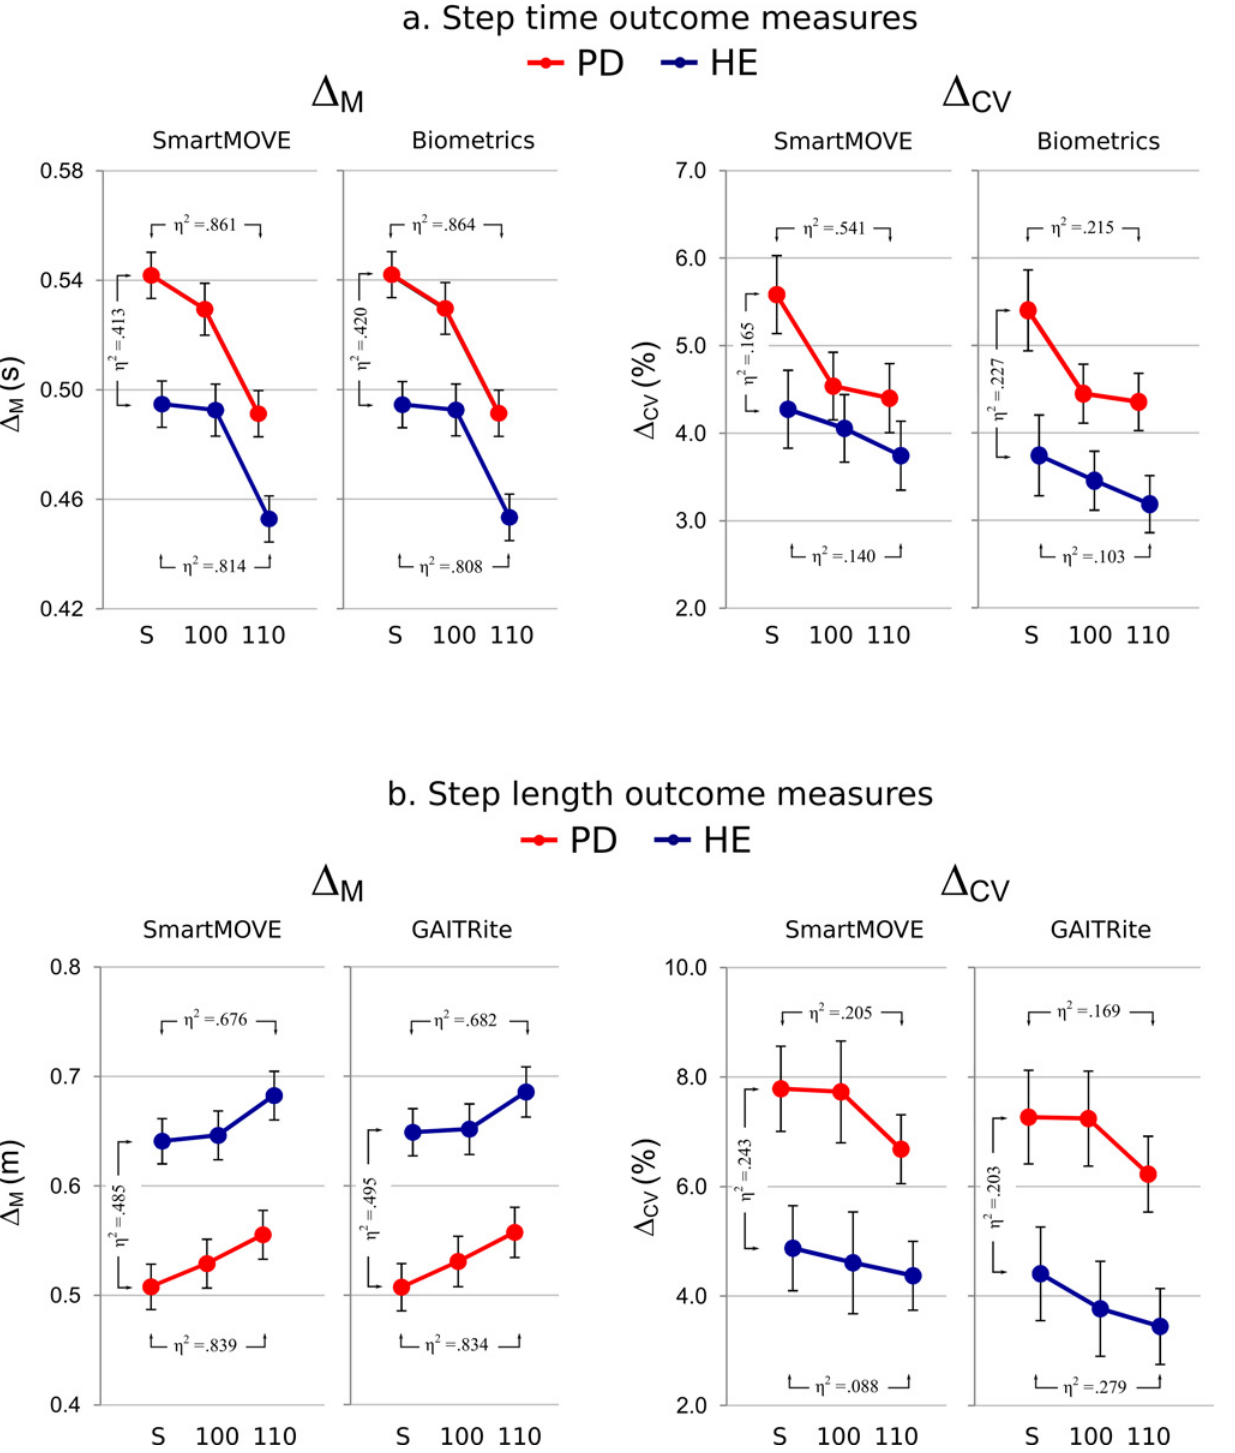
Fig 2. Outcome measure results. Results of the Group (separate lines: PD vs. HE) × Condition ( x -axis: self-paced, 100% RAC, 110% RAC) × Device (separate panels: SmartMOVE vs. heel contact – based) ANOVAs for step time (a.) and step length (b.) outcome measures.